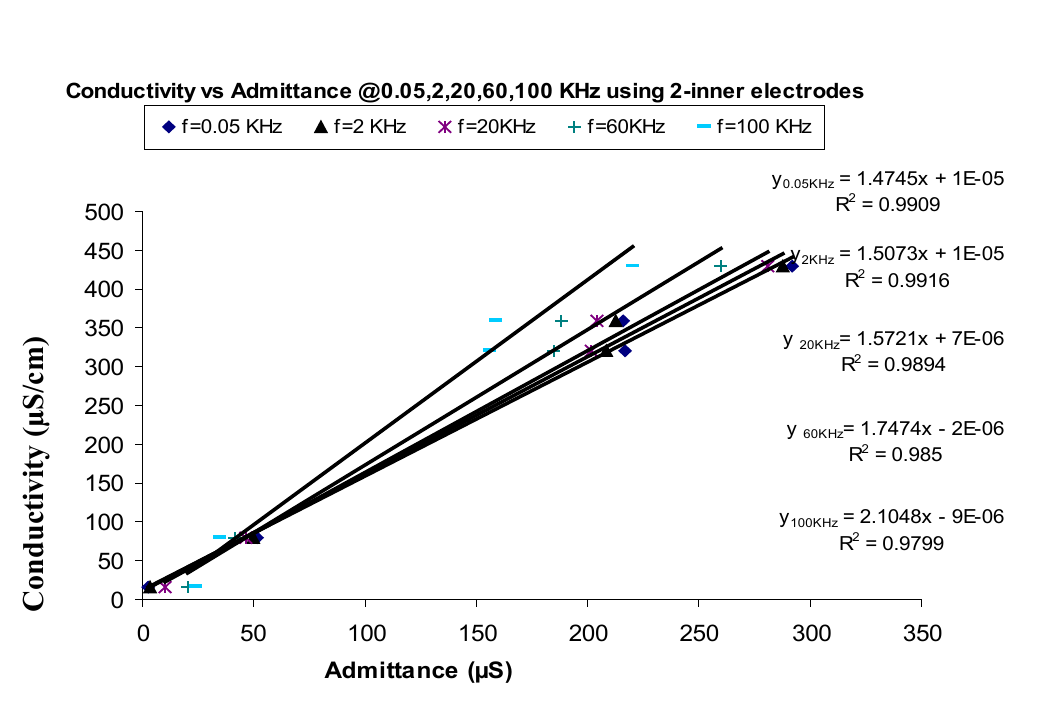
2-Inner Electrodes